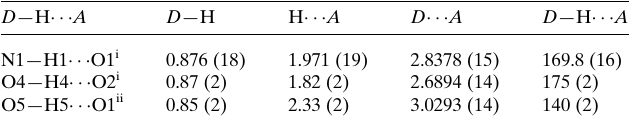
Table 4 Hydrogen-bond geometry (A˚ , (cid:2) ) for II. Table 5 Hydrogen-bond geometry (A˚ , (cid:2) ) for III.